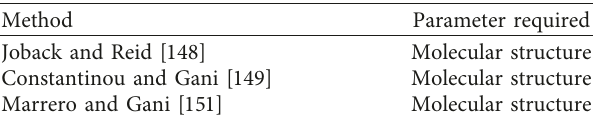
Table 7: Methods for the normal melting point